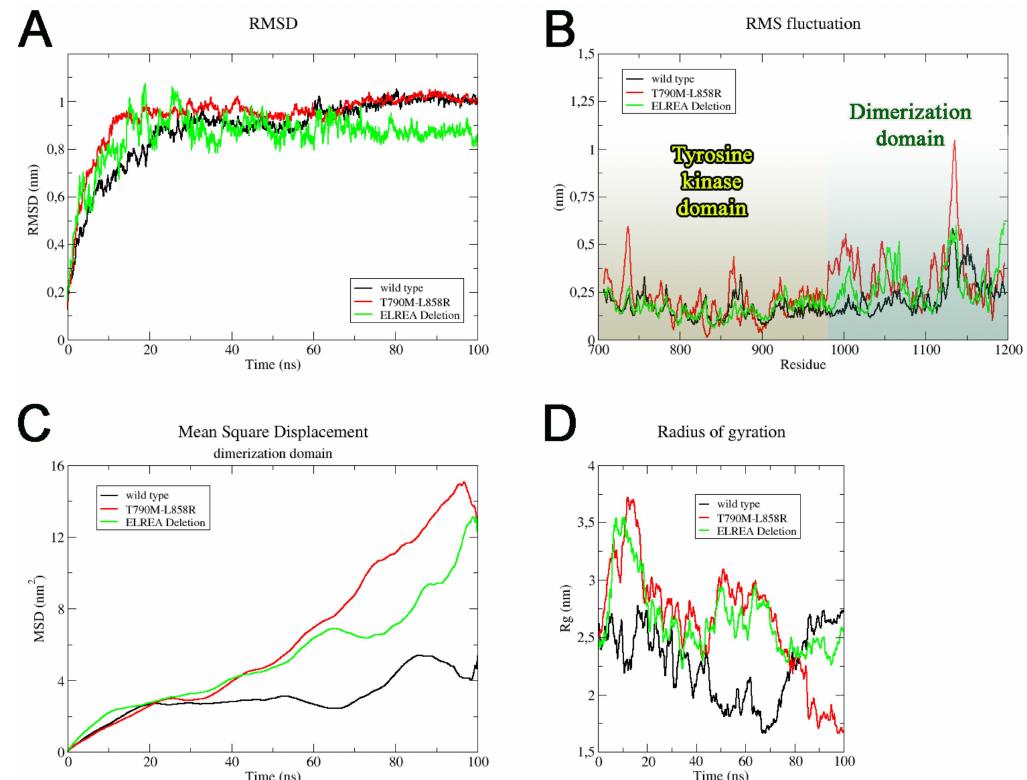
Figure 5. Structural analysis of EGFR cytoplasmic di ff erent forms. We reported root-mean-square deviation (RMSD) ( A ), root-means-square fluctuation (RMSF) ( B ), mean square displacement (MSD) of the dimerization domain ( C ) and radius of gyration (Rg) ( D ), For all graphs we reported the wild type, the T790M / L858R and ELREA deletion forms (black, red and green,